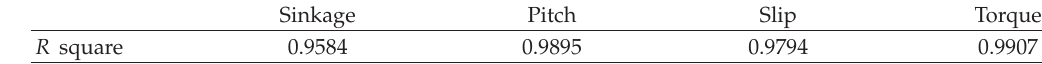
Table 1: R square of crawler kriging